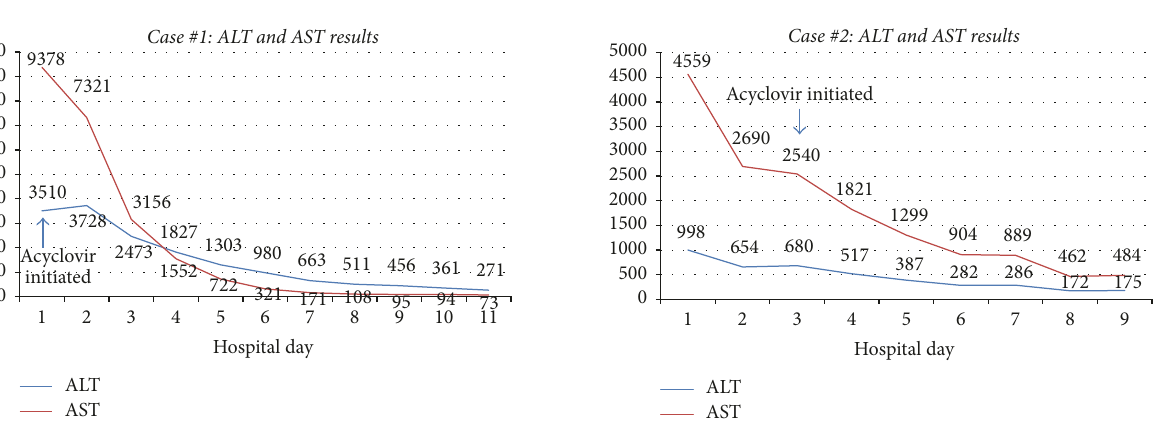
Figure 1: Case #1 trend in ALT and AST. ALT: alanine aminotrans- ferase; AST: aspartate aminotransferase.